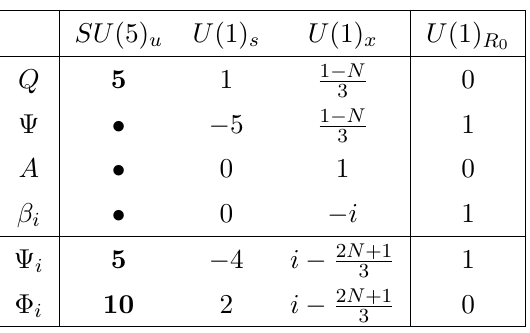
Table 10 . Transformation rules of the matter fields of theory T A and theory T B under the global